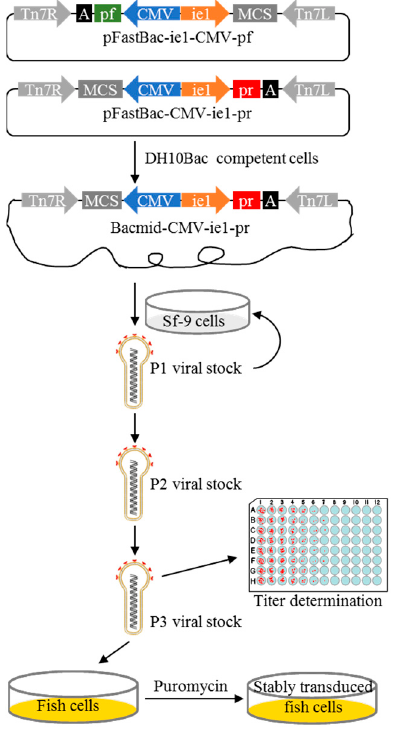
Figure 1. Construction of shuttle plasmid and illustration of recombinant baculovirus production and transduction of fish cells. In plasmid pFastBac-ie1-CMV-pf/pFastBac-CMV-ie1-pr, a puromycin–red fluorescent protein (Puro-RFP, pr ) or puromycin–green fluorescent protein (Puro-GFP, pf ) reporter cassette was driven by a cytomegalovirus (CMV) or white spot syndrome virus (WSSV) immediate-early gene 1 (ie1) (WSSV ie1) promoter, and an adjacent WSSV ie1 or CMV promoter was used to express the gene of interest in the reverse direction. The donor plasmid was transformed to DH10Bac competent cells to generate Bacmid, which was then transfected to Sf-9 cells to obtain the baculovirus. The baculoviral stock was amplified by infecting Sf-9 cells and titrated and transduced into fish cells. MCS, multiple cloning sites. A, poly(A). P1 (P2, P3) viral stock, Passage-1 (-2, -3) viral stock.